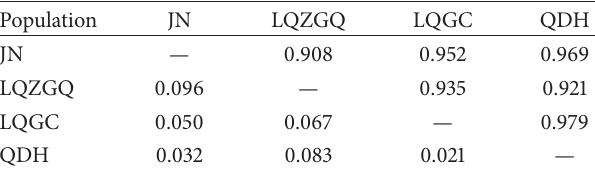
Table5:Nei’sgeneticdistance(belowthediagonal)andNei’sgenetic identity (above the diagonal) of natural populations in O. fragrans .